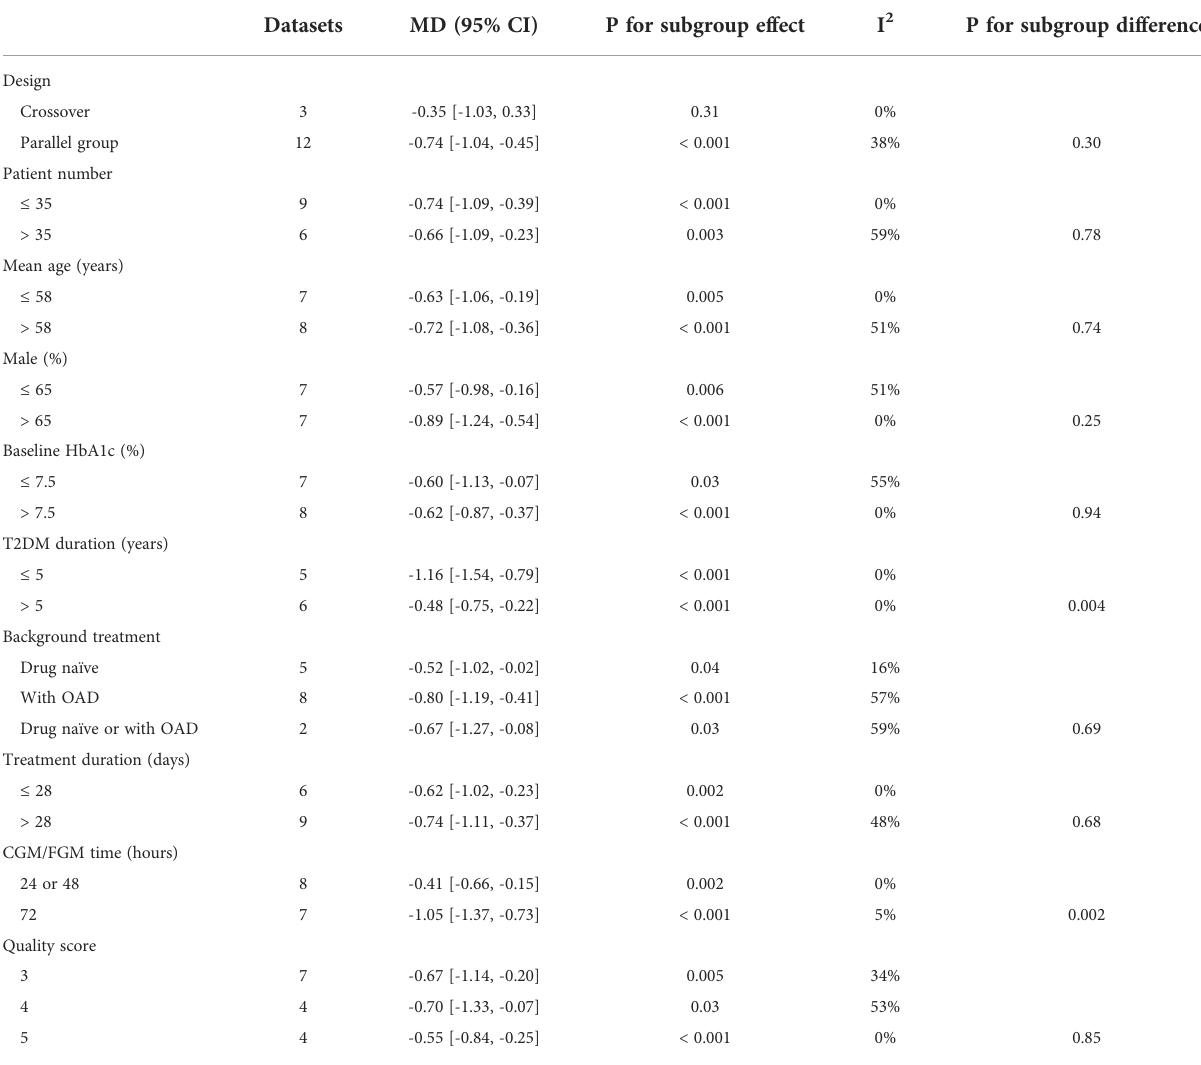
TABLE 3 Subgroup analysis for comparing DPP4 inhibitors with other OADS on